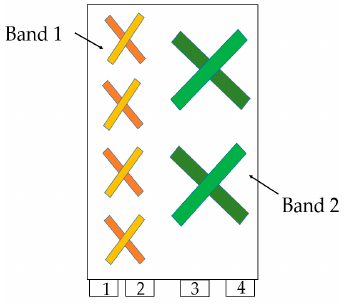
Figure 9. A dual-band antenna.